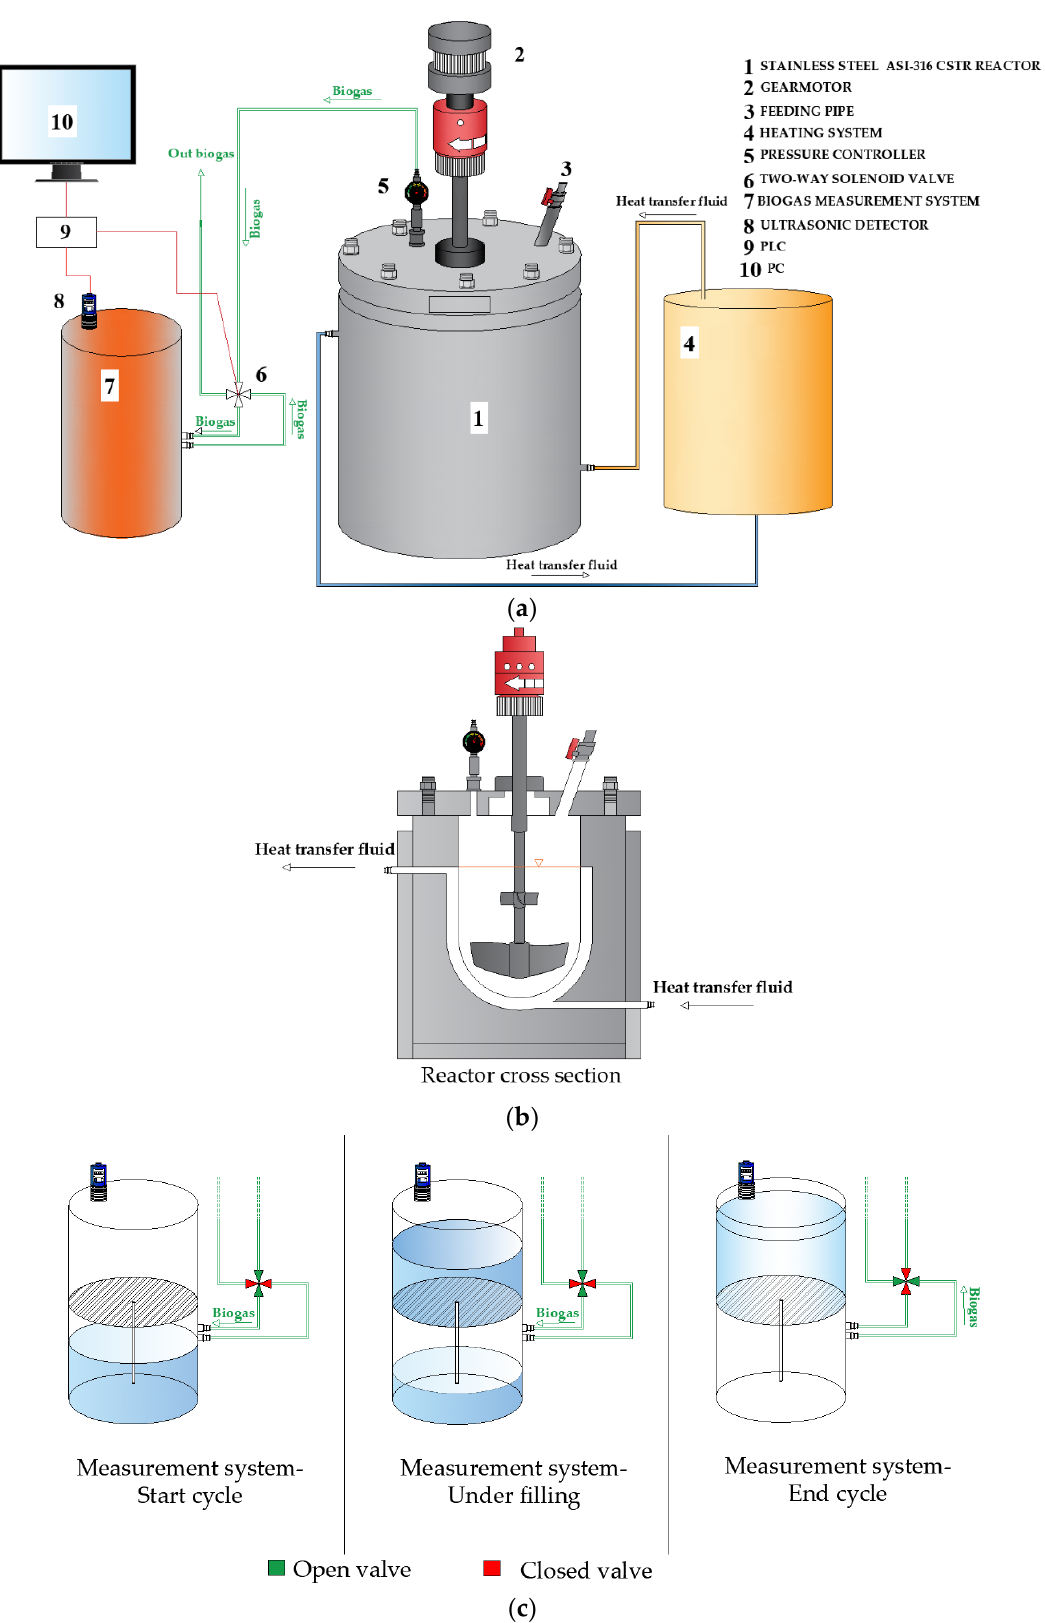
Figure 1. PAD laboratory pilot plant ( a ); reactor cross section ( b ); biogas measurement system ( c ).